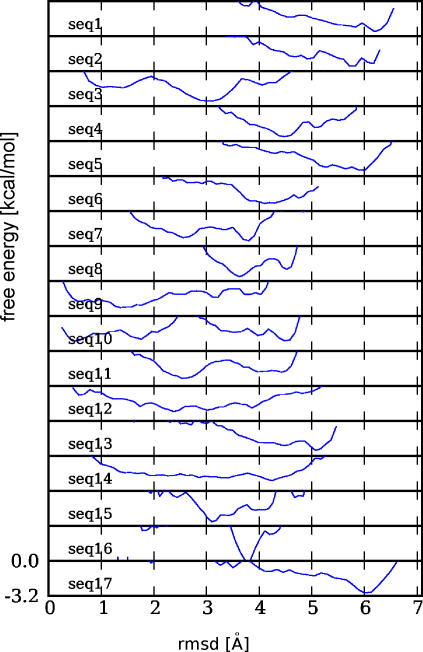
Free-Energy Profile of RMSD of Peptides from Protein G